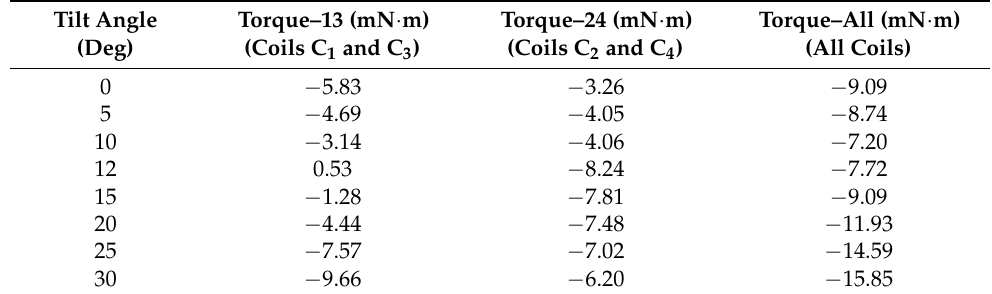
Figure 10. The change in torque with respect to the tilt angle along the X -axis for the ( a ) X -axis (or Y -axis) and ( b ) Z -axis. Table 2. The values of the torque with respect to the tilt angle along the X -axis for the X -axis (or Y -axis).